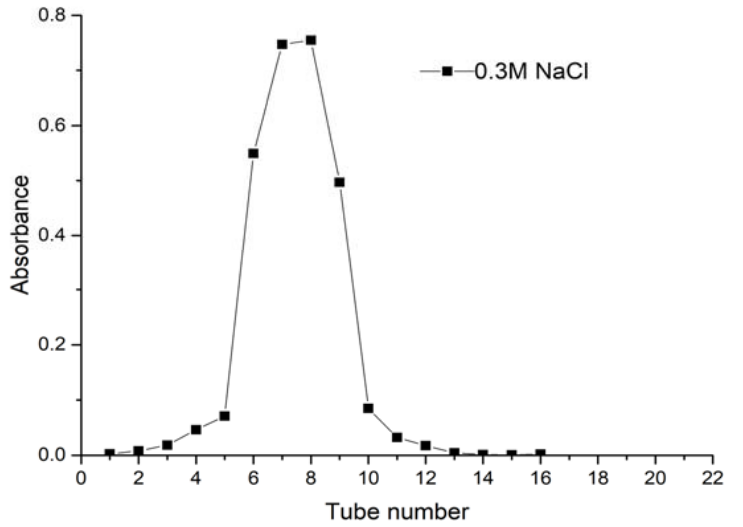
Figure 2. The elution curve of CALP-1 Sephadex G-100 column chromatography.